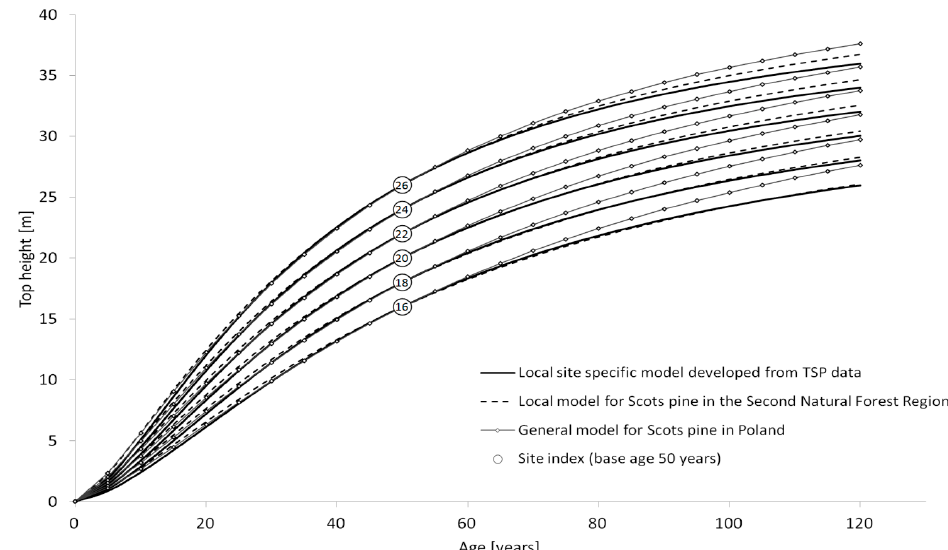
Figure 5. Top height change trajectories for Scots pine according to the model developed using TSP data, the reference model for Scots pine for the Second Natural Forest Region, and the general model for Scots pine in Poland. The values in circles represent the corresponding site index at the base age of 50 years.